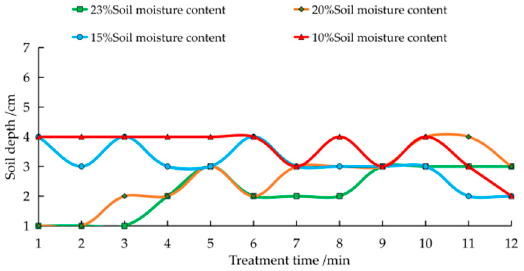
Figure 37. The maximum temperature ⎯ T n max of the black soil internal test point.